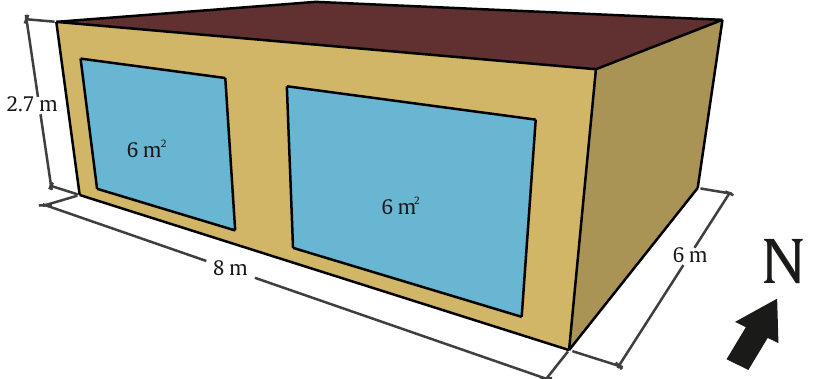
Figure 1. Isometric view of the baseline building employed (BESTEST